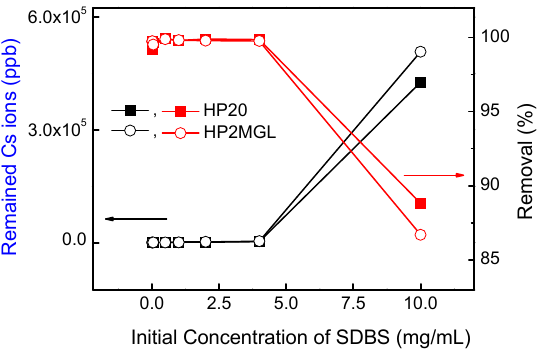
Figure 7. Effect of initial SDBS concentration for the removal of SDBS by ( a ) HP20 and ( b ) HP2MGL from SDBS/Cs. [adsorbents] = 5 mg/mL; adsorption time = 7 h. To investigate whether Cs ions were removed by the resins from SDBS/Cs solution simultaneously with SDBS, the concentration of Cs ions that remained after adsorption by the MARs was measured. More than 85% of Cs ion removal was attained by both MARs (Figure 8). This result suggests that when the SDBS was removed from SDBS/Cs solution by the MARs, Cs ions were removed together with the SDBS.